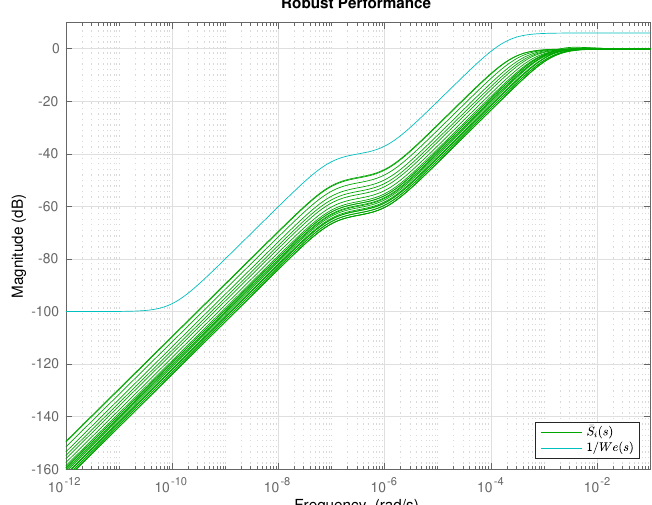
Figure 18. Approximated robust performance check for the closed-loop system step response with ¯ C i ( s ) and W (cid:48) e ( s )